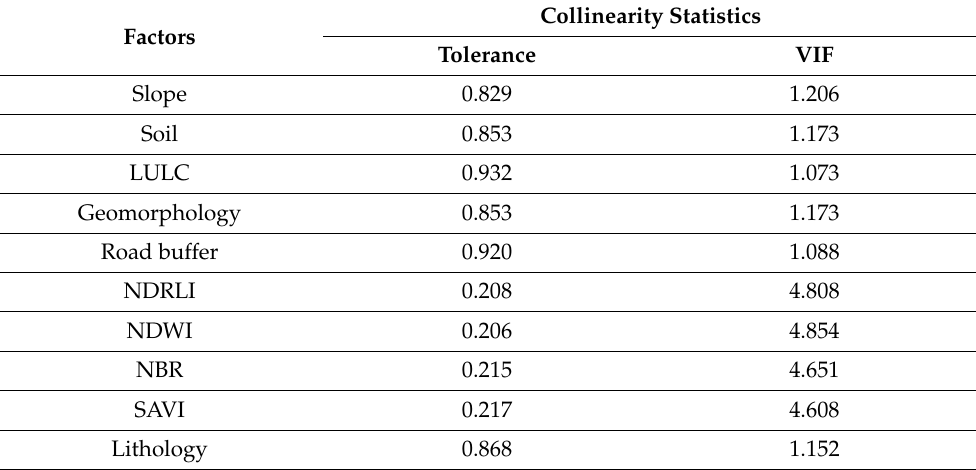
Table 8. Collinearity